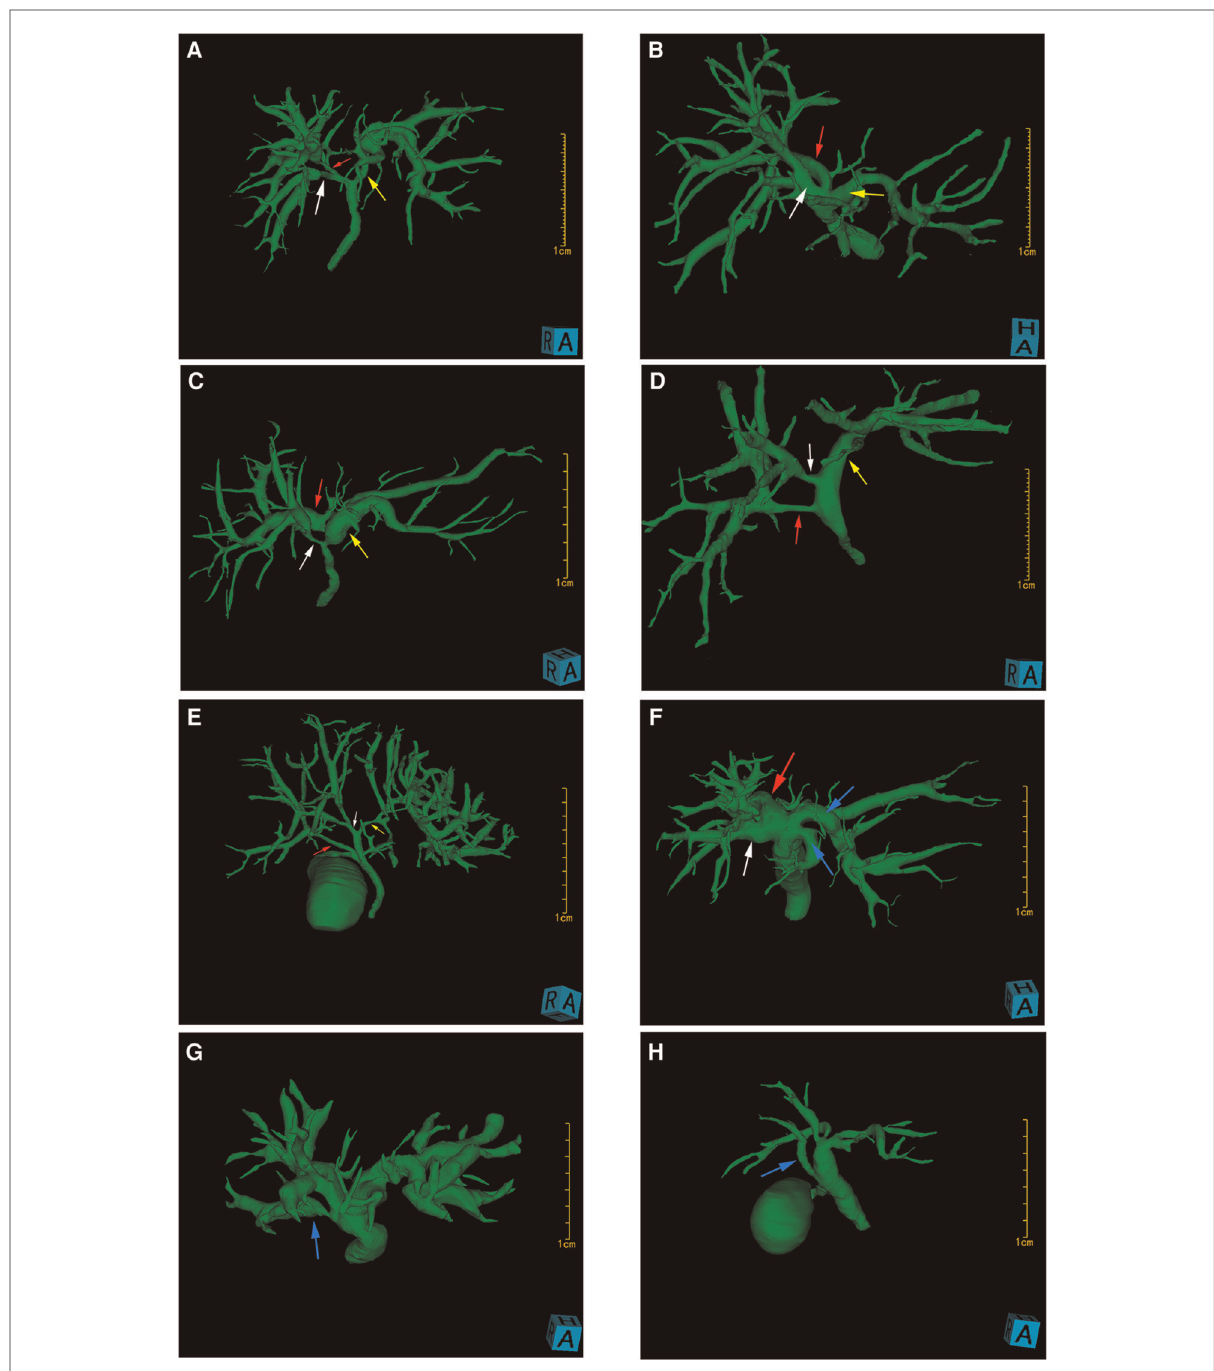
FIGURE 2 3D biliary tract model reconstructed by the Hisense CAS system. The white arrowheads indicate RASD, the red arrowheads indicate RPSD, the yellow arrowheads indicate LHD, and the blue arrowheads indicate variant bile ducts. ( A ) shows typical intrahepatic bile duct anatomy (type I), i.e., RASD (white arrowhead) forms RHD with RPSD (red arrowhead), which in turn forms CHD with LHD. The bile duct shown in ( B ) is classi fi ed as type II, indicating triple con fl uence, i.e., RASD, RPSD, and LHD drain into the CHD. ( C ) is a type III variant showing abnormal RPSD drainage to LHD. ( D ) shows an abnormal RPSD drainage to CHD, and ( E ) presents a rare variant showing RPSD drainage to the cystic duct, and is classi fi ed as type V. In ( F ), the bile duct draining segment 4 (blue arrowhead) and the bile duct draining segments 2 and 3 (blue arrowhead) are inserted into CHD, respectively, and there is no left main hepatic duct in this variant. Accessory hepatic ducts (blue arrowhead) are present in both ( G ) and ( H ), which are classi fi ed as type VIIa and type VIIb, respectively, according to the opening position of the accessory hepatic ducts. In type VIIa, AHD is inserted into RHD, not accompanied by other types of variations, while in type VIIb, AHD can be observed opening into the hepatic duct, accompanied by a variation of type